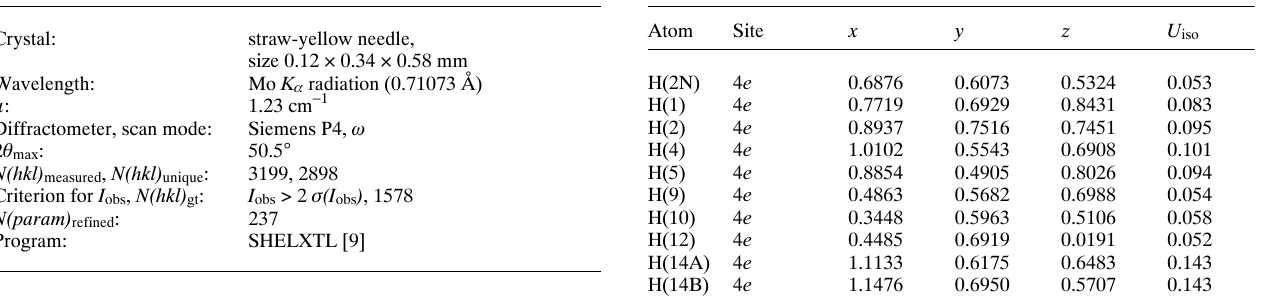
Table 1. D a t a collection a nd h a ndling. Table 2. A tomic coordin a tes a nd displ a cement p a r a meters (in Å 2 )